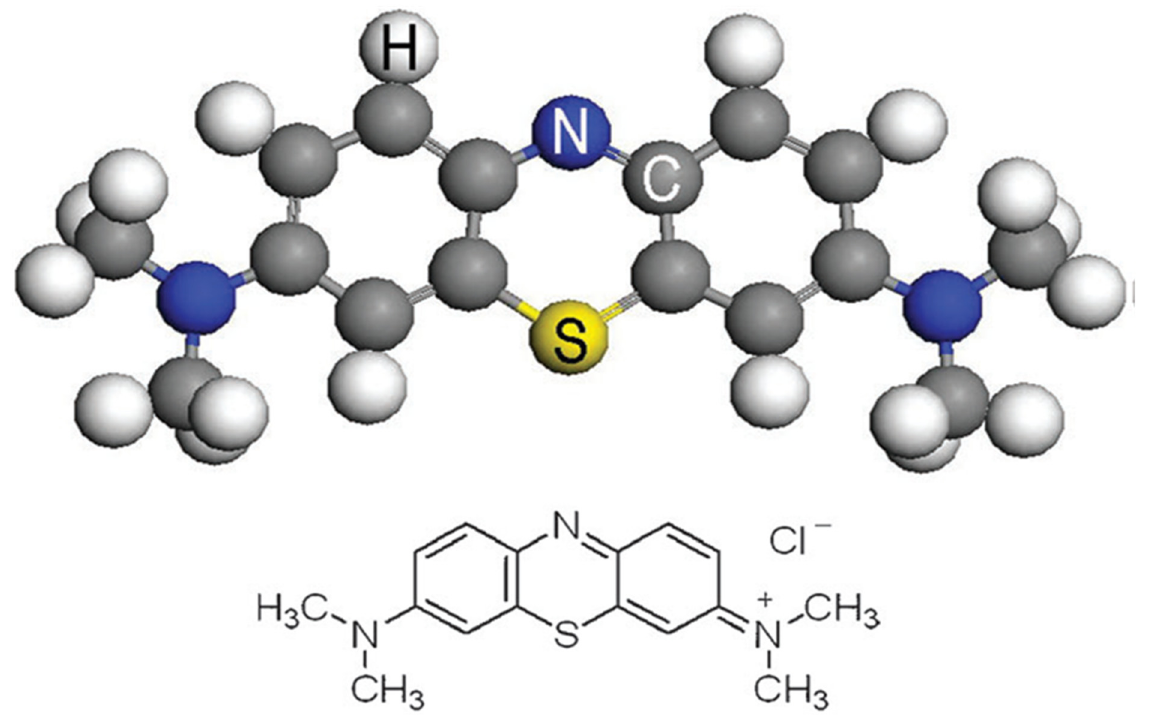
Figure 2. The model and the structure of MB dye molecule [29] (Adapted with permission from the Royal. Society of Chemistry (license ID 1079849-1).